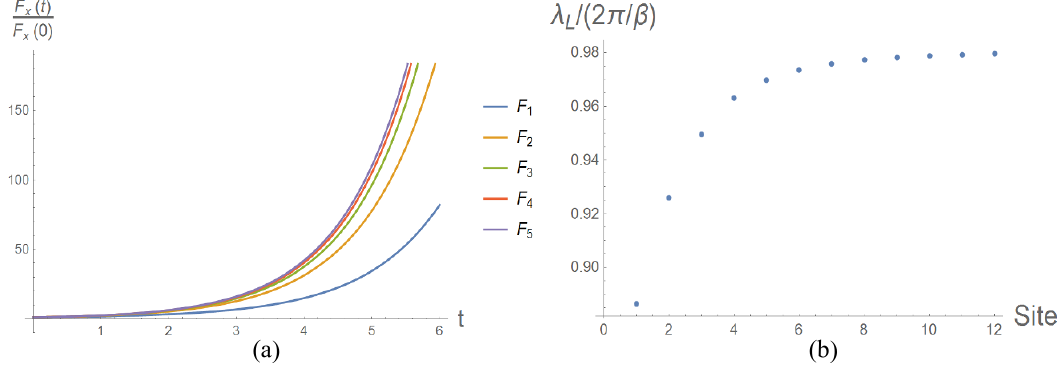
Figure 8 . (a) Di(cid:11)erent behavior of F 1 ( t ) (cid:24) F 5 ( t ). (b) Fitted Lyapunov exponent from the behavior of F x ( t ) after the dissipation time (cid:12)= 2 (cid:25) . (cid:12) = 2 (cid:25) , J = u = 100 are